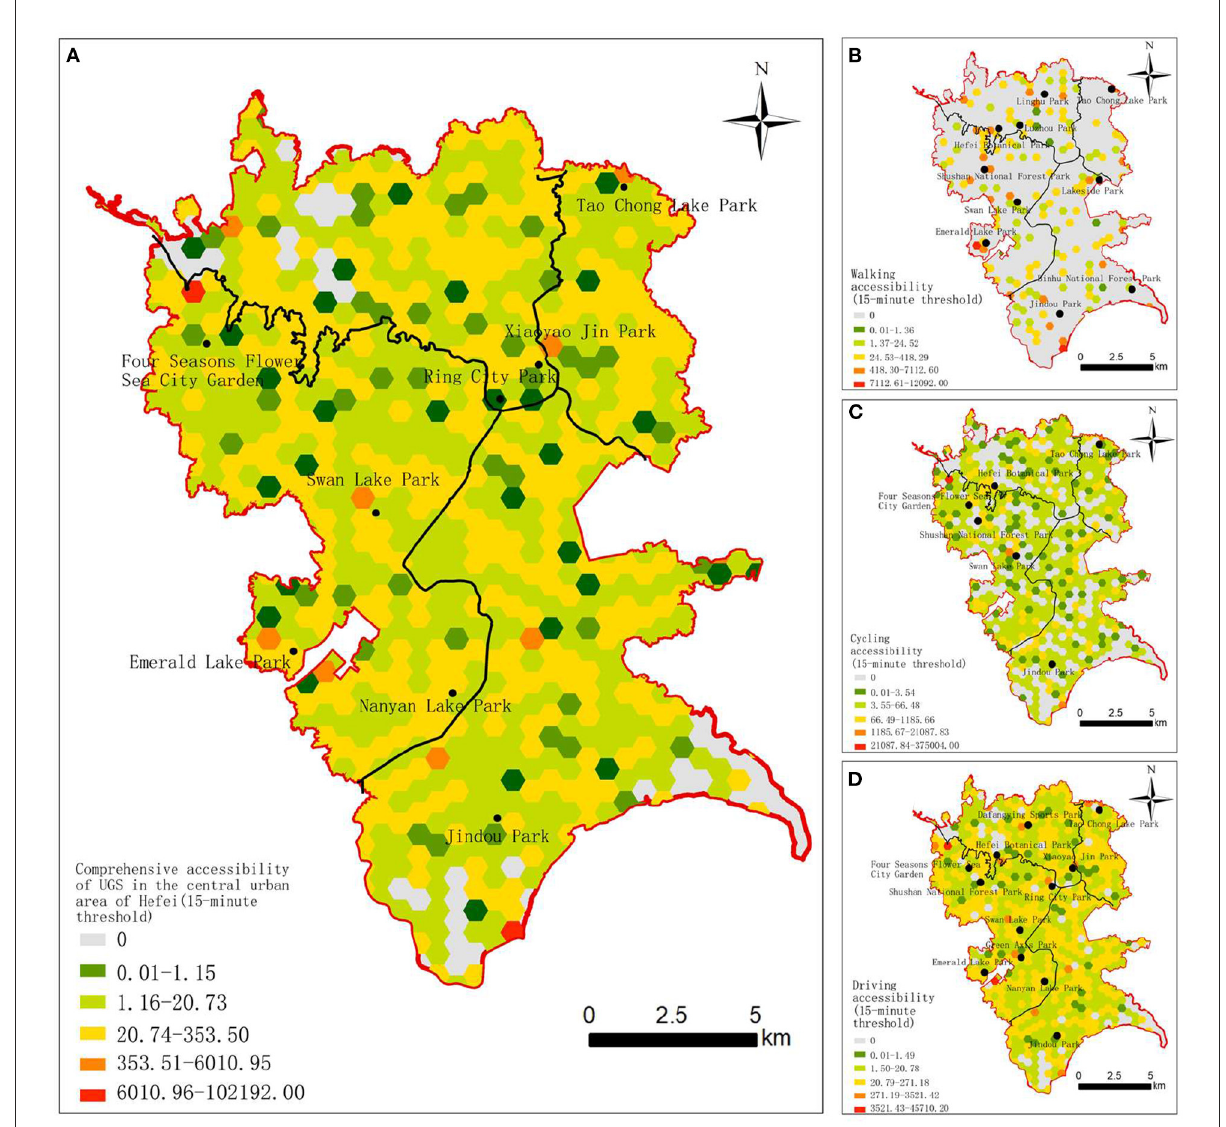
FIGURE4 Accessibility of UGS in the central urban area of Hefei at the 15-min threshold. (A) Comprehensive accessibility. (B) Walking accessibility. (C) Cycling accessibility. (D) Driving